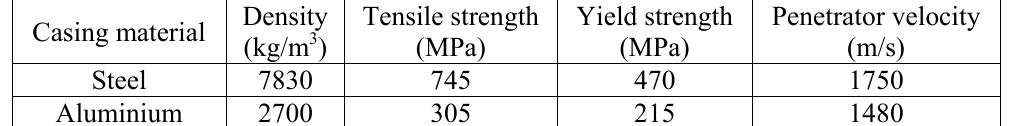
Table 1. Characteristics of materials used for EFP’s casing and their influence on penetrator velocity